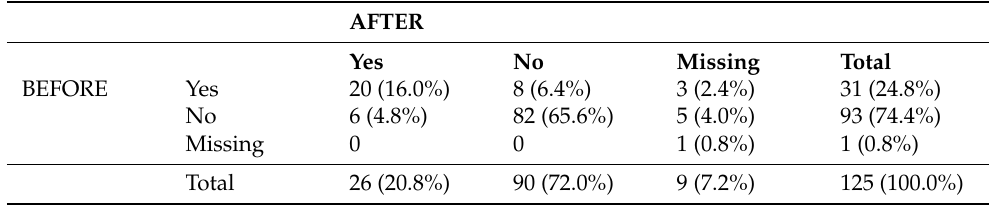
Table 3. Comparison of problematic use before and after the regulatory change for GP office patients’ problematic users ( n = 125).